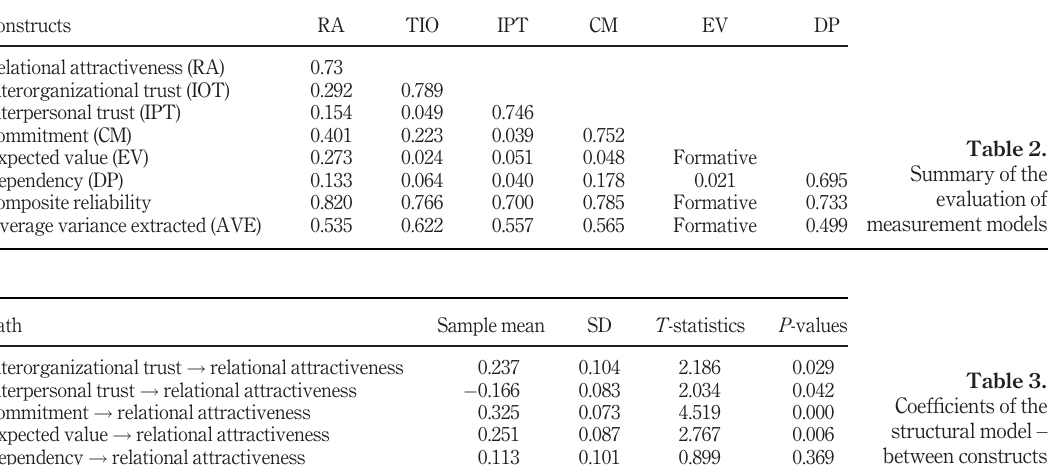
Table 3. Coef fi cients of